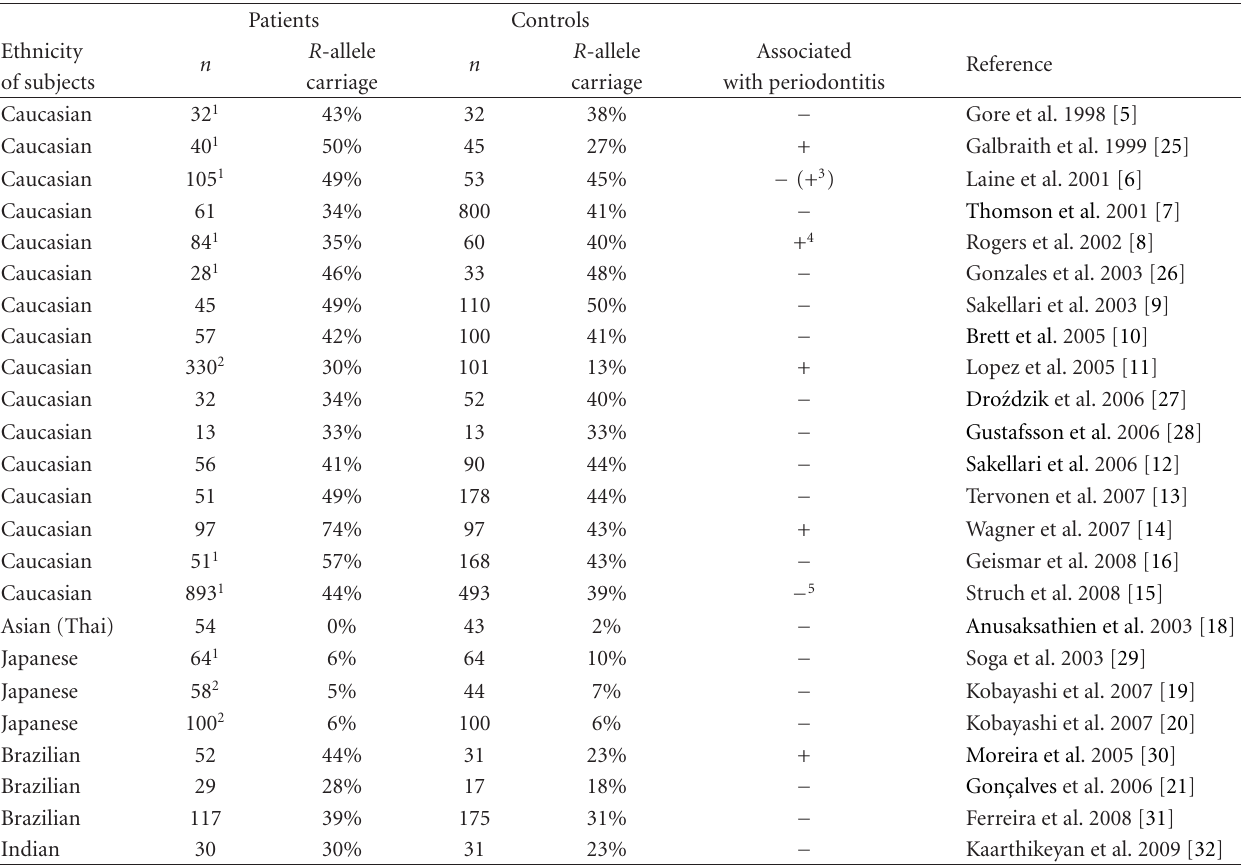
Table 2: IL1B +3954 (+3953) C > T gene polymorphisms and carriage rate of the Rare ( R )-allele in case-control studies and association with susceptibility to chronic